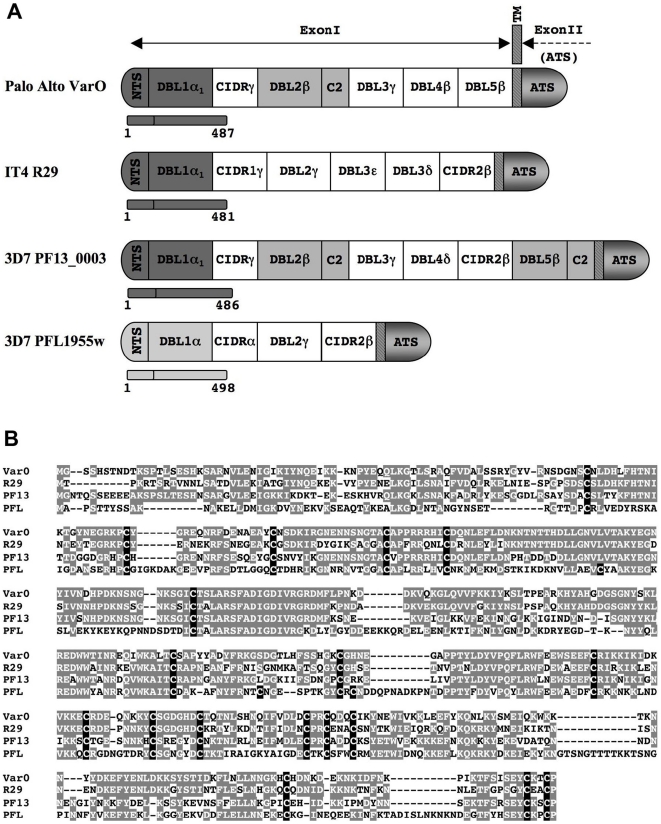
Domain organisation of the PfEMP1 proteins and sequence comparison of the NTS-DBL1α domains.(A) Schematic domain organisation of the Palo Alto/varO, IT4/R29, 3D7/PF13_0003 and 3D7/PFL1955w PfEMP1 proteins. Regions corresponding to the recombinant NTS-DBL1α domains are indicated by bars, with the N- and C-terminal residue numbers giving sequence limits. Domains in dark grey have >50% sequence identity, shaded DBLβ domains have ∼38% identity; DBL1α-PFL1955w is shown in light grey (29–33% identity). (B) The NTS-DBL1α sequences aligned as described in the Materials and Methods. Cysteine residues are shown in white on a black background and residues with 50% or more sequence identity are shown in white on a grey background.